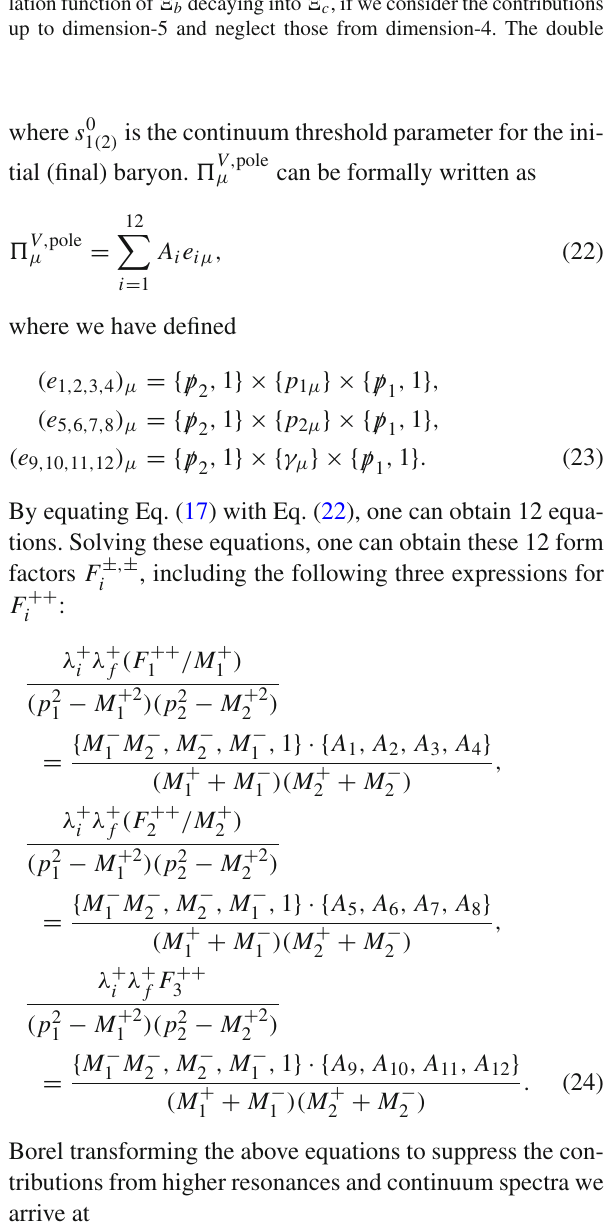
lines denote the heavy quarks, the dots stand for the condensates, and the cross marks are vertices of weak interaction